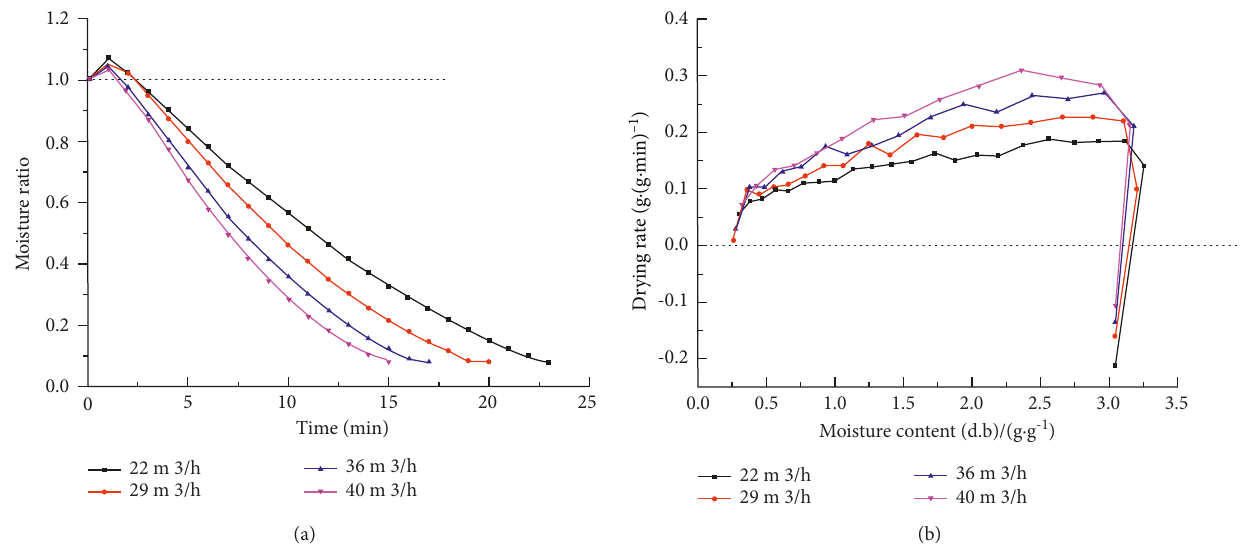
Figure 4: Drying curves and drying rate curves of 6 mm sludge at different sludge flow under steam temperature of 220 ° C. (a) Drying curves. (b) Drying rate